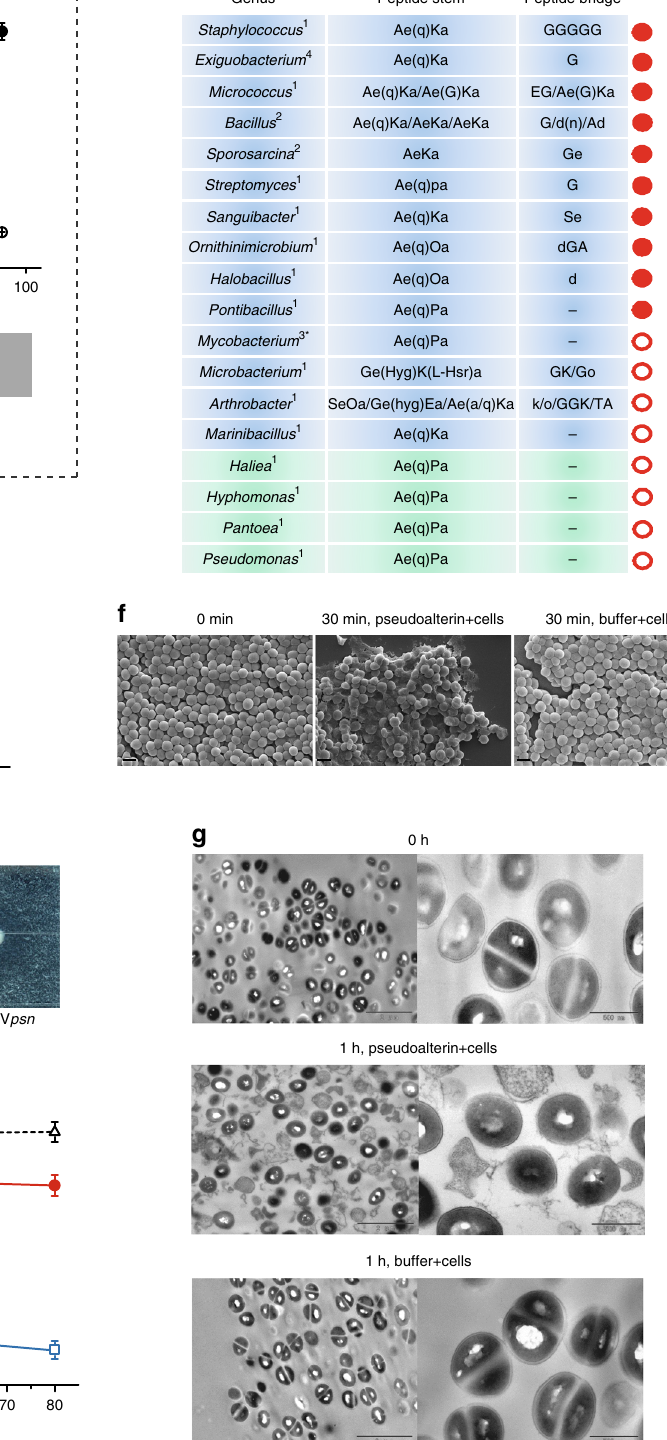
other Gram-positive bacteria 12 . Pseudoalterin synthesis is thus speci fi cally induced by glycine and glycine-enriching oligopep- tides derived from Gram-positive bacterial PG. Pseudoalterin is secreted via a type II secretion system . The type II secretion system (T2SS) of strain CF6-2 is encoded by a set of 12 gsp (general secretion pathway) genes, including a